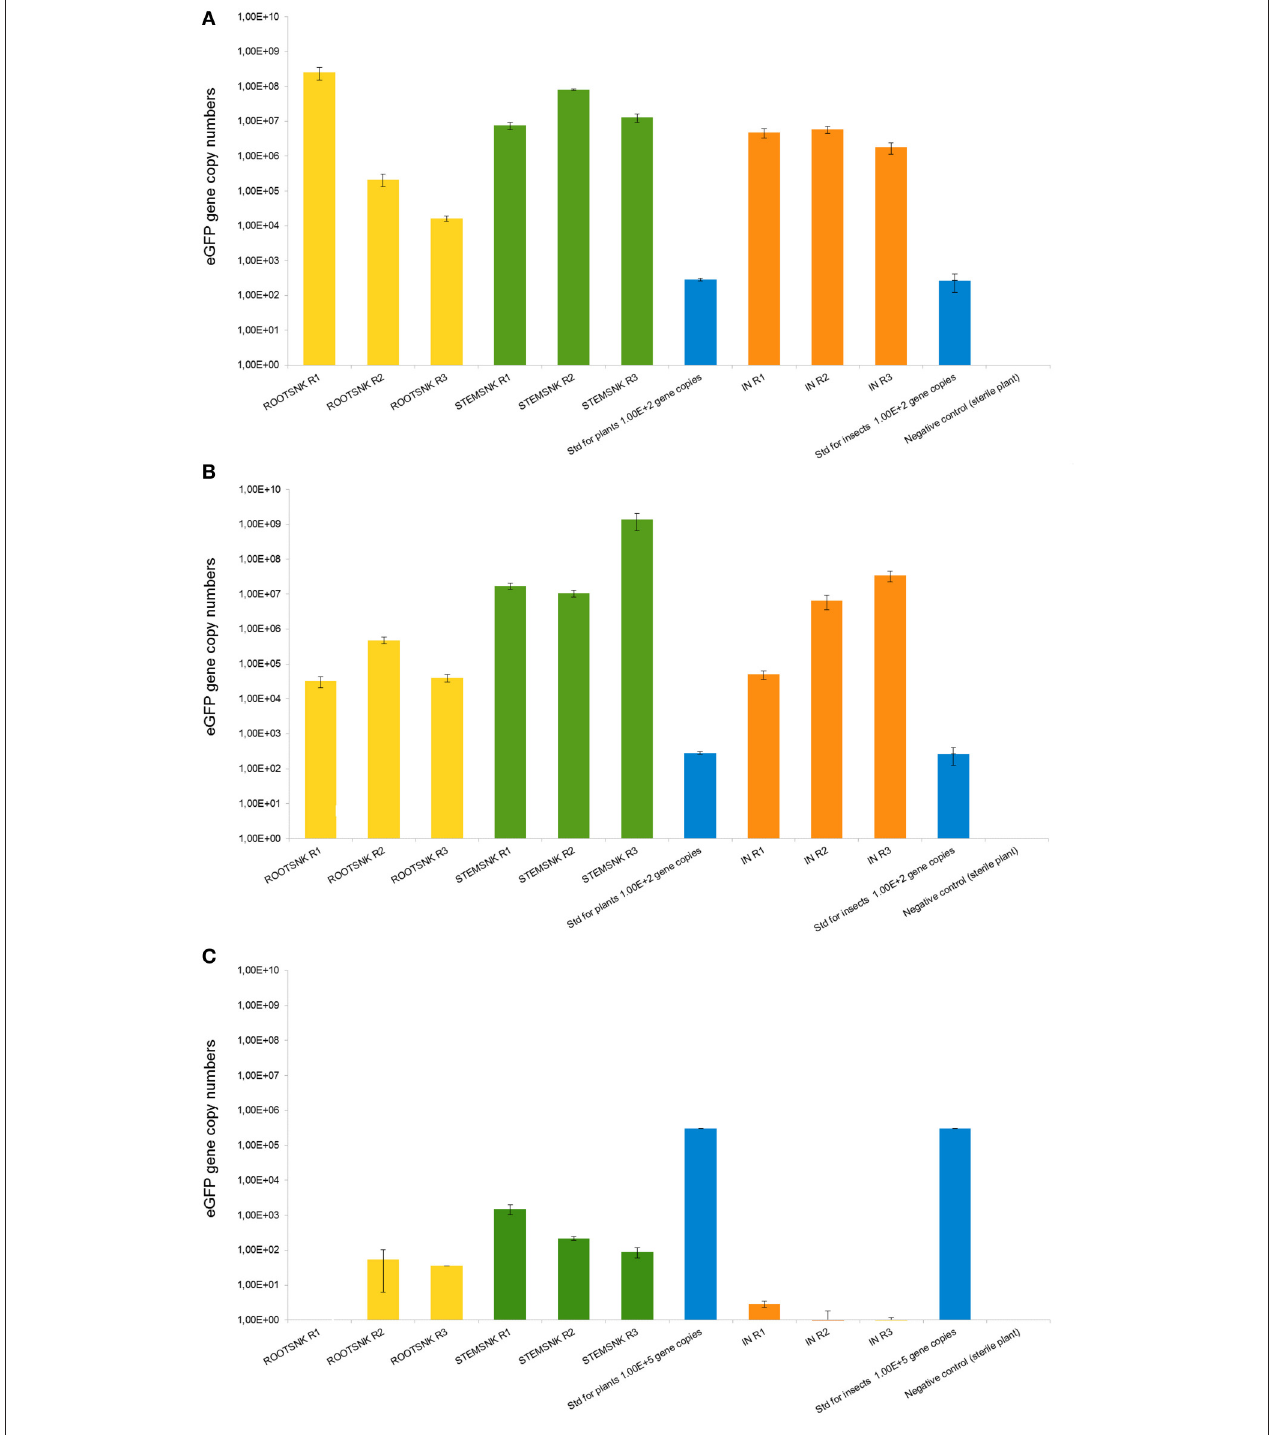
FIGURE 6 | Quantification of eGFP gene copy numbers in the plants and insects used in transmission experiments. Gene copy numbers in the eGFP-bearing plasmid pMP4655 were quantified using qPCR with the second derivate method. For plants, the values obtained were benchmarked against the fresh weight (g) of samples; for insects, the copy numbers per individual are shown. Bars represent the mean of five biological replicates per treatment. Error bars represent the standard deviation of the mean. (A) Quantification of eGFP in Enterobacter ludwigii EnVs2. (B) Quantification of eGFP in Enterobacter ludwigii EnVs6. (C) Quantification of eGFP in Pantoea vagans